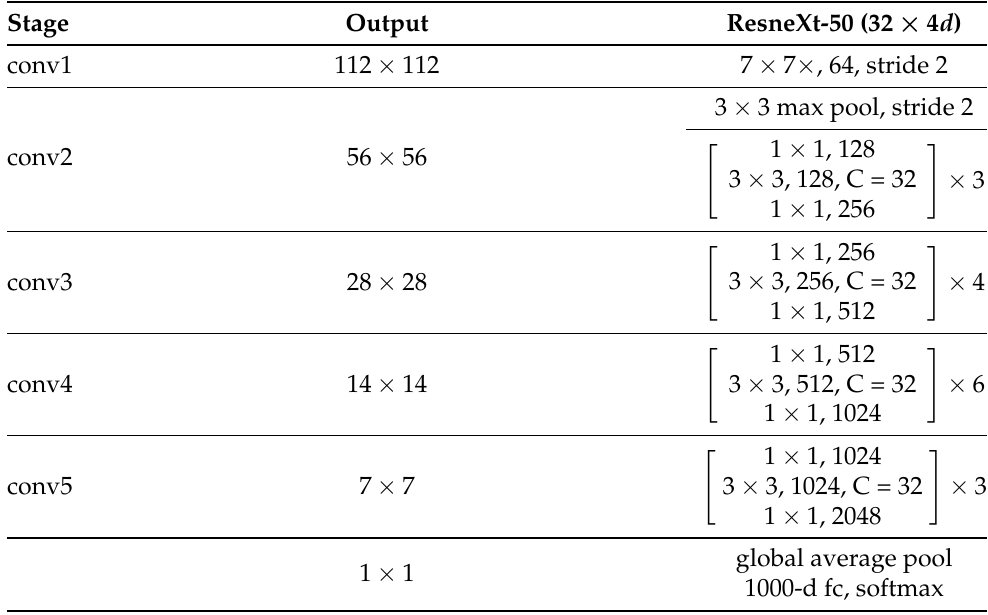
Figure 3. A ResneXt Module with cardinality = 32, with roughly the same complexity. A layer is shown as (# in channels, filter size, # out channels) [34]. Table 4. ResneXt-50 with a 32 × 4 d template. Inside the brackets is the shape of a residual block, and outside the brackets is the number of stacked blocks on a stage. (C = 32) suggests grouped convolutions with 32 groups